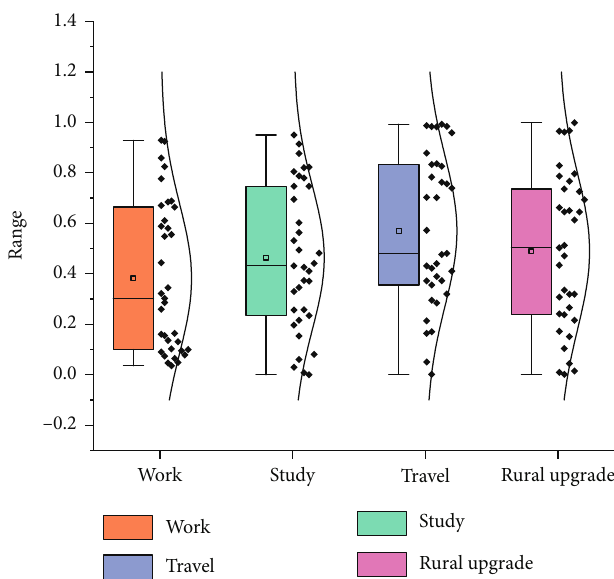
Figure 7: The application status of multimedia technology in various industries from 2010 to 2020.